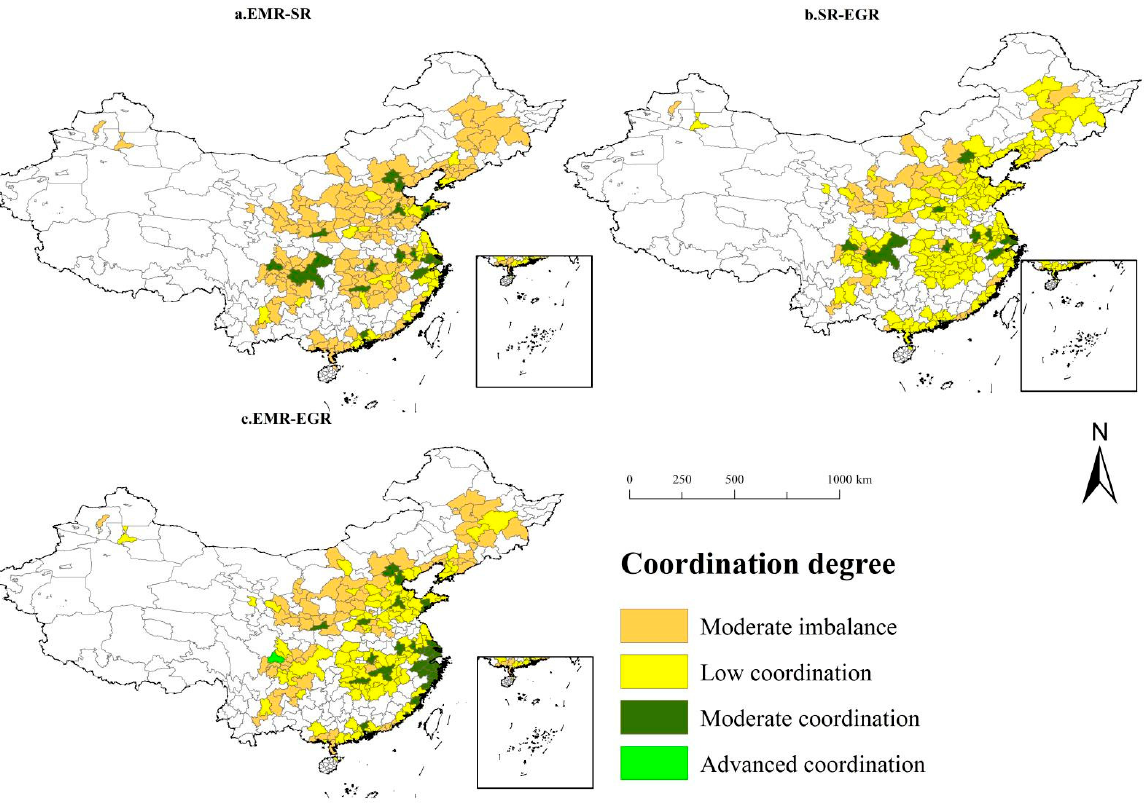
Figure 6. The two coupling coordination degrees.